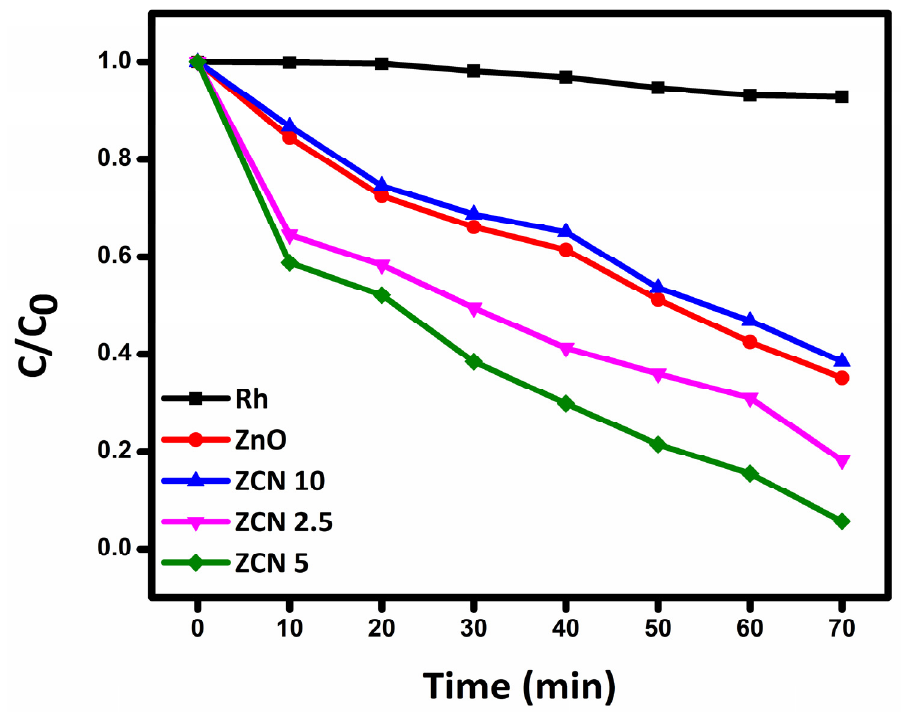
Figure 8. Photocatalytic degradation curves of RhB by ZnO and its composites ZnO/C 3 N 4 .